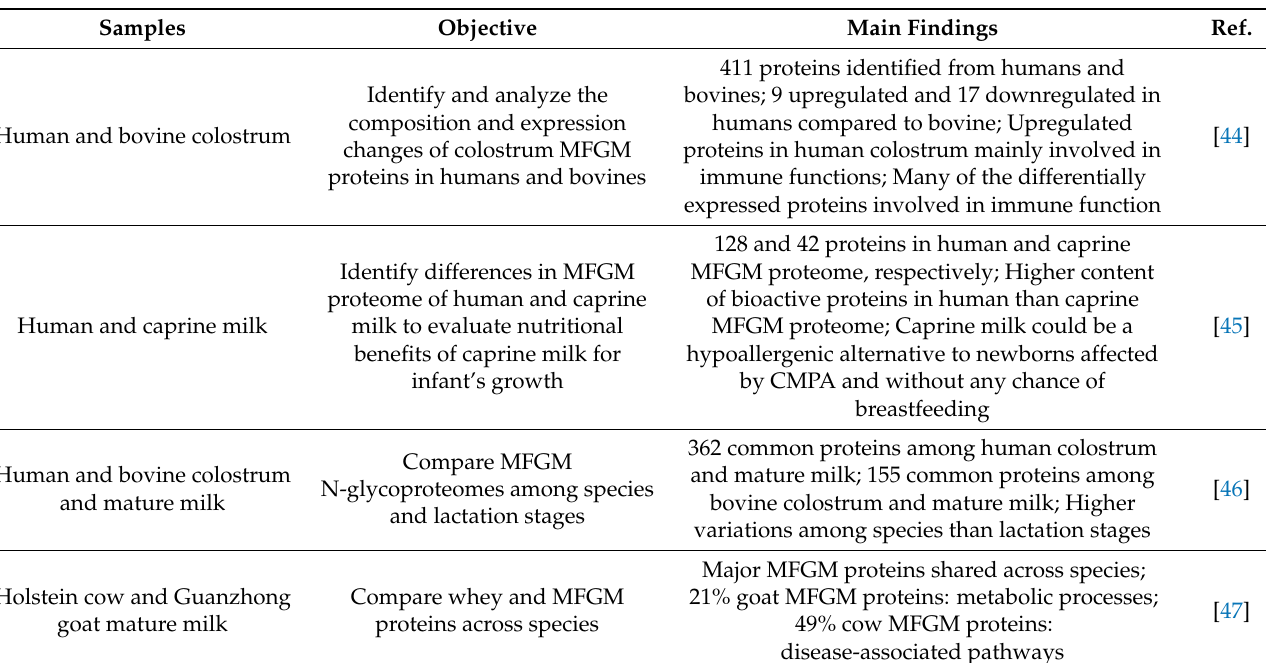
goat (95 proteins, R = 0.60) and yak (76 proteins, R = 0.62). These data are also reported in Figure 1. In addition, BTN, ADPH, FABP and MUC1 are the major MFGM proteins and are shared among the two species [22,29]. These major proteins were identified as being the most abundant also in sheep MFGM proteome [28]. Dairy 2021 , 2 , x FOR PEER REVIEW